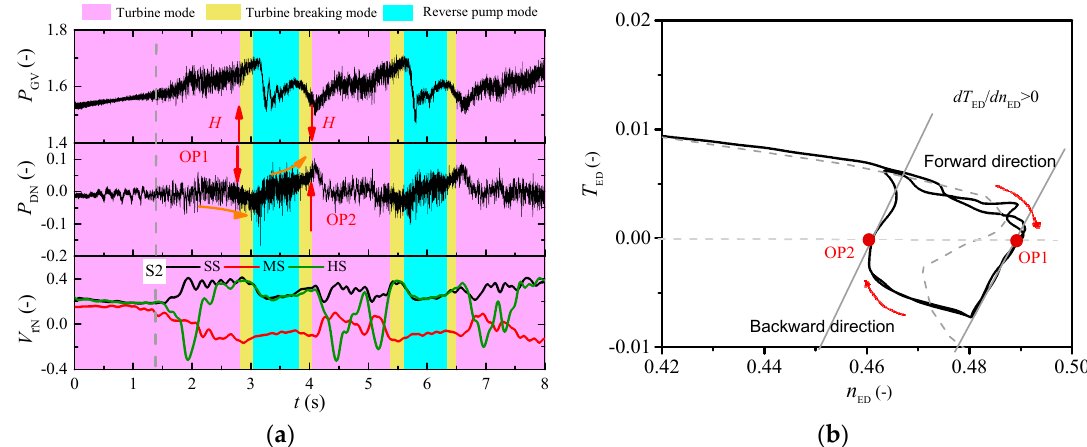
Figure 5. Dynamic trajectories and time histories of operating parameters at GVO 9°. ( a ) Variation of pressure and radial velocity; and ( b ) dynamic trajectories.